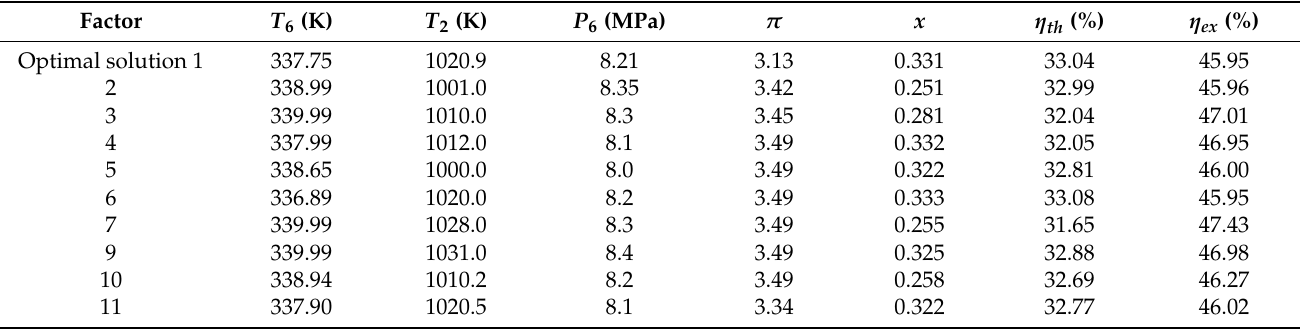
Table 6. The partial Pareto optimal solution for η th and η ex